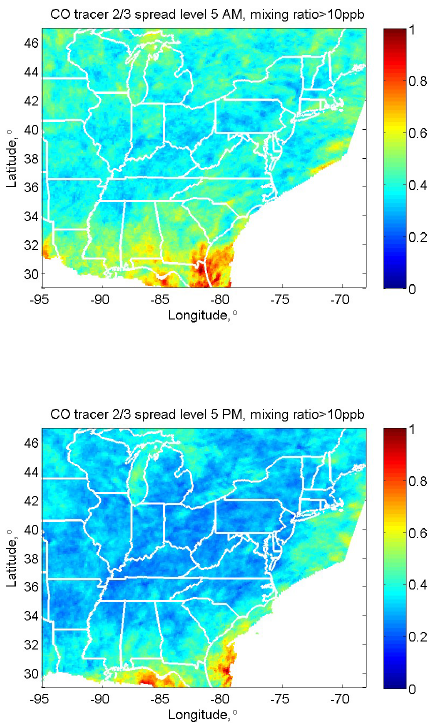
Figure 10: Mean ensemble spread of tracer mixing ratio at level 5 (400-500 m AGL). The 564 Figure 10. Mean ensemble spread of tracer mixing ratio at level 5 averages are taken over all 49 days and hours 0400-0600 LST (AM, top) and 1300-1500 LST (PM, 565 (400–500ma.g.l.). The averages are taken over all 49 days and bottom). The spread is normalized by the mean mixing ratio at each point. Points with small mean 566 hours 04:00–06:00LST (AM, top) and 13:00–15:00LST (PM, bot- tom). The spread is normalized by the mean mixing ratio at each values (<10 ppbv) are masked out. 567 point. Points with small mean values ( < 10ppbv) are masked